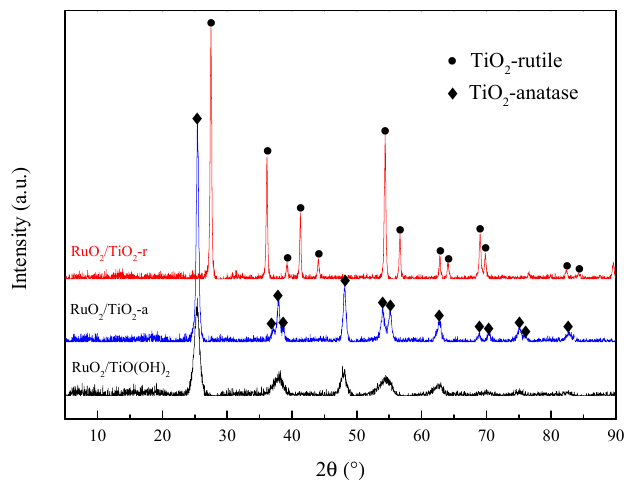
Figure 1. XRD patterns of the RuO 2 /TiO 2 catalysts with the supports of: TiO 2 -rutile, TiO 2 -anatase, and TiO(OH) 2 (as the precursor).